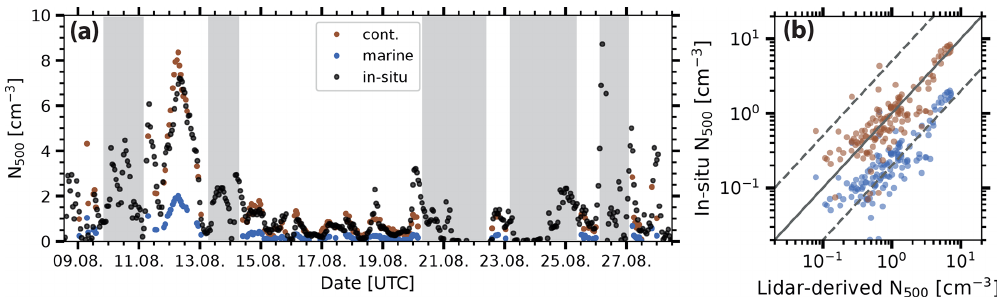
Figure 13. (a) Time series (during sample 10, 11, and 12) of in situ measured N > 500 nm in black dots, and lidar-retrieved N > 500 nm when assuming a lidar ratio typical for marine or continental particles in blue and brown dots, respectively. The periods without lidar profiles are marked in gray. (b) The in situ measured N > 500 nm against the lidar-retrieved N > 500 nm when assuming a lidar ratio typical for marine or continental particles (during sample 10, 11, and 12) in blue and brown dots, respectively.